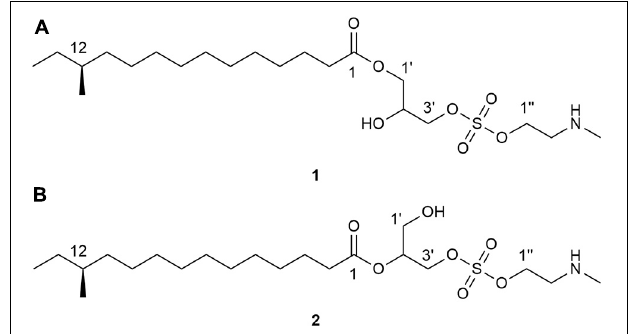
FIGURE 2 | Structures of lenzimycins A and B ( 1 - 2